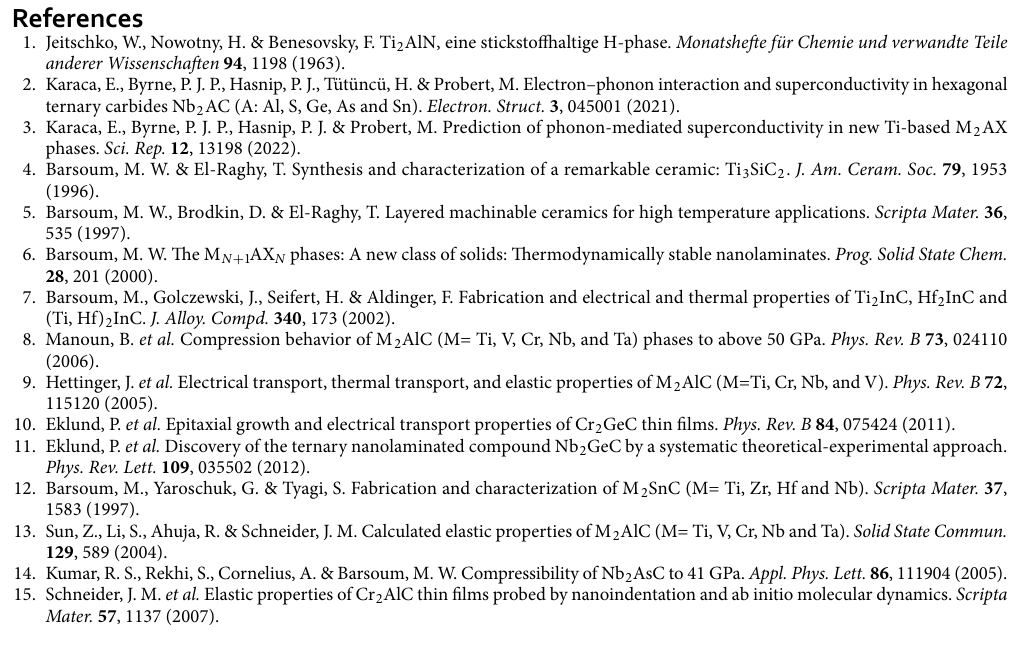
Figure 6. The calculated phonon properties of Cr 2 AlN. ( a ) dispersion curves, ( b ) total and partial phonon density of states, and ( c ) the calculated electron–phonon spectral function α of the electron–phonon coupling parameter (blue line) with rising frequency (cid:31) ( ω ). ( d ) Calculated wavevector- dependent electron–phonon coupling parameter for the 3 acoustic modes and 2 optical modes along the high symmetry lines in the Brillouin